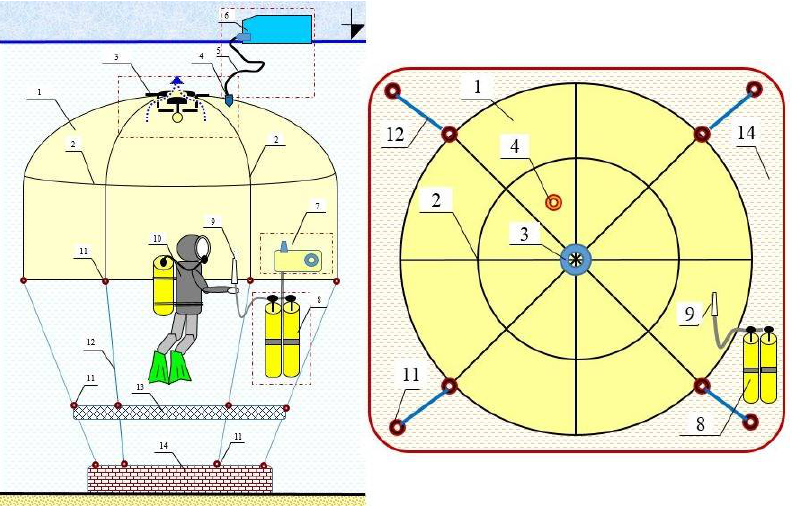
Figure 1. Project of Batychron—a flexible underwater bell: 1. Displacement module (dome); 2. Straps with a retaining net; 3. Measurement and control module with accessories; 4. Supporting module; 5. Flexible hose; 6. Breathing container; 7. The system that cleans the mixture of respiratory gases; 8. Breathing mix reservoir; 9. Breathing mix drain; 10. Diver; 11. “U” connector with a screw plug; 12. Liaison module with load, bearing belts; 13. Diving platform; 14. Anchor module. Source: Own research (2021).